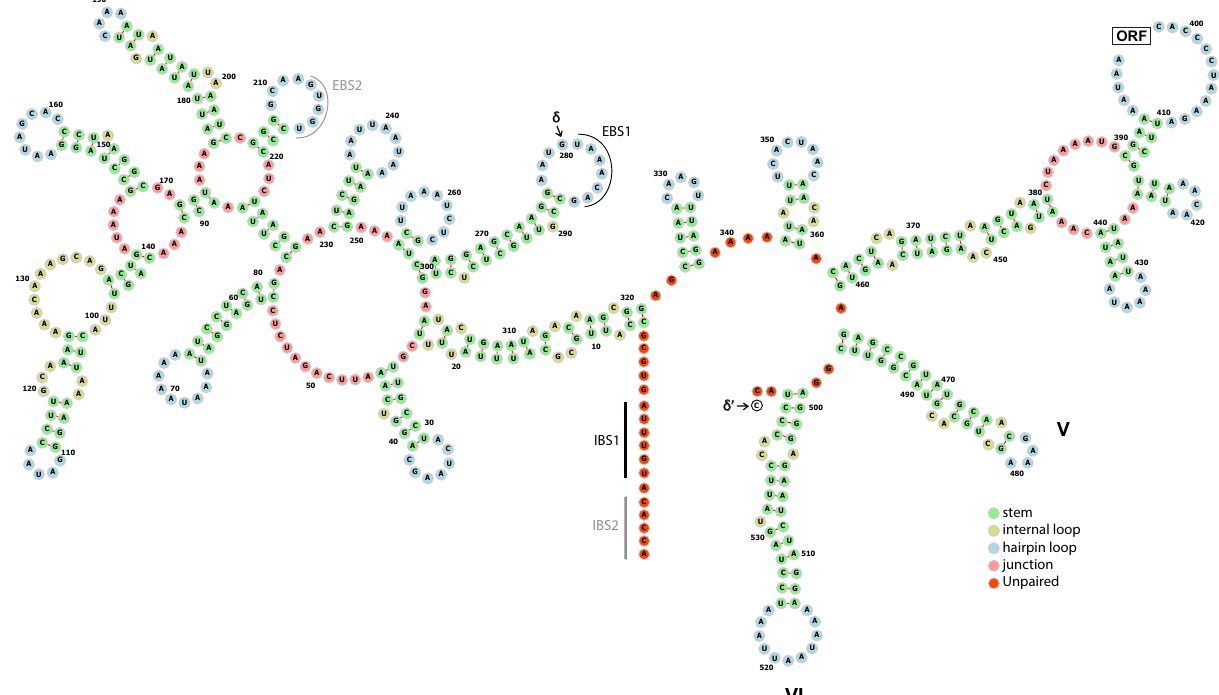
Figure 4. Putative secondary structure drawing of EV-cox1 intron ( Exechonella vieirai ). The intron-encoded protein open-reading frame (ORF) was excised prior to folding. Domains V and VI and intron-binding site IBS1 and corresponding exon-binding site EBS1 are indicated. Less certain IBS2 and EBS2 sites are indicated in grey. Tertiary interaction sites delta (δ) and delta prime (δ’) are labelled. Nucleotides are coloured according to their positions in the secondary